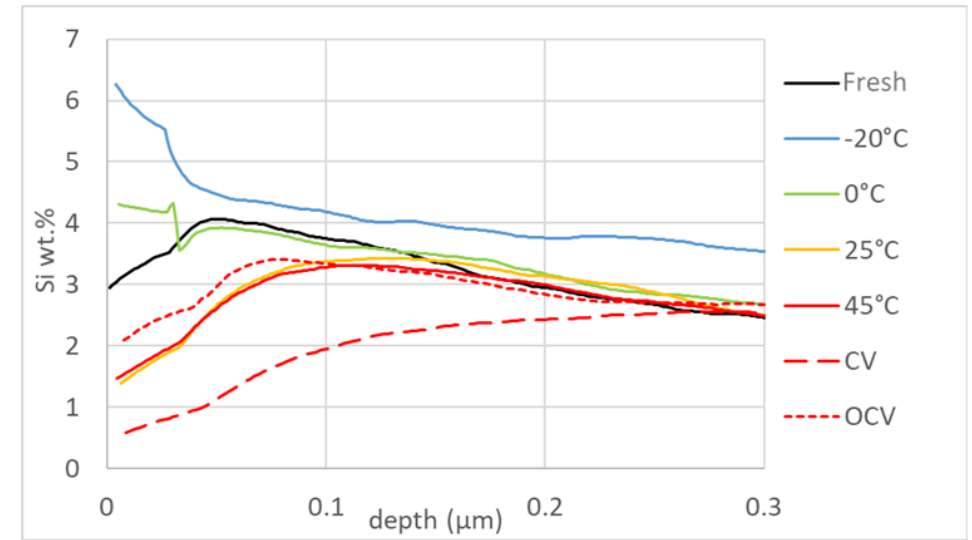
Figure 8. Si concentration of the surface (0.3 first µm) for fresh and aged negative electrodes from 30Q cell.